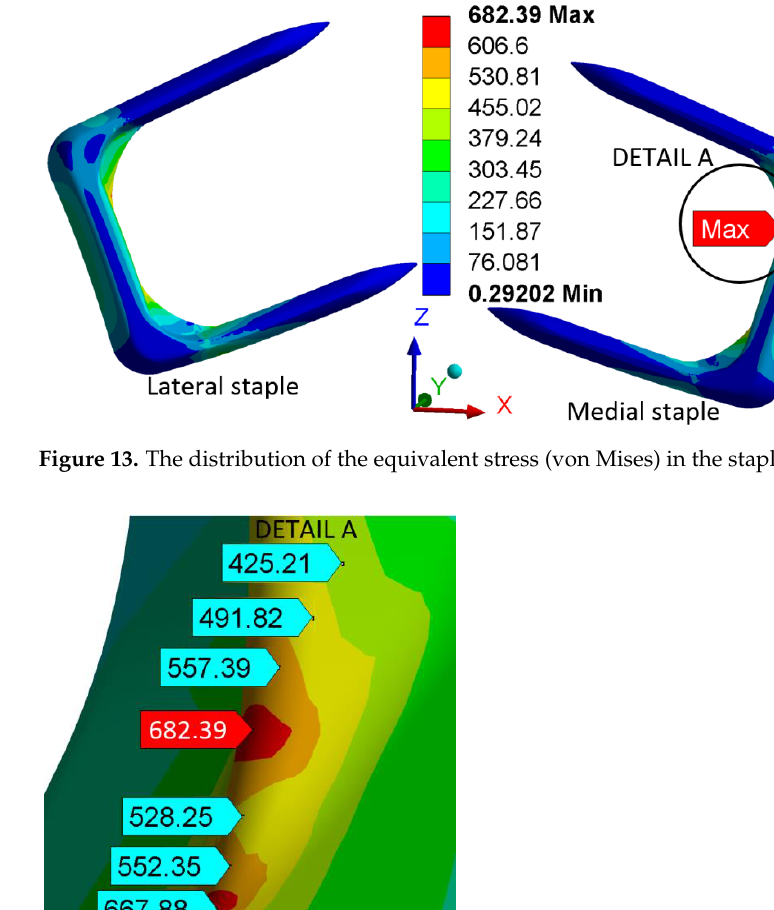
Figure 14. Detail “A” (see Figure 13) of the location with the maximum equivalent stress (von Mises) in the medial staple and with marked values near the maximum (MPa).